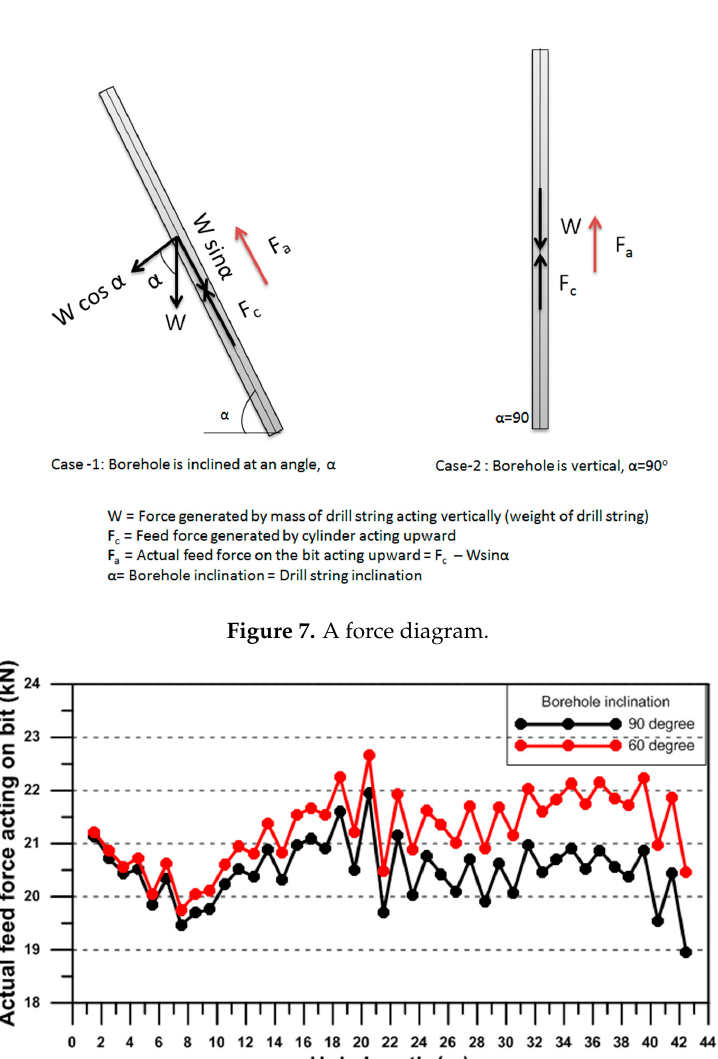
Figure 6. Feed force versus hole length.